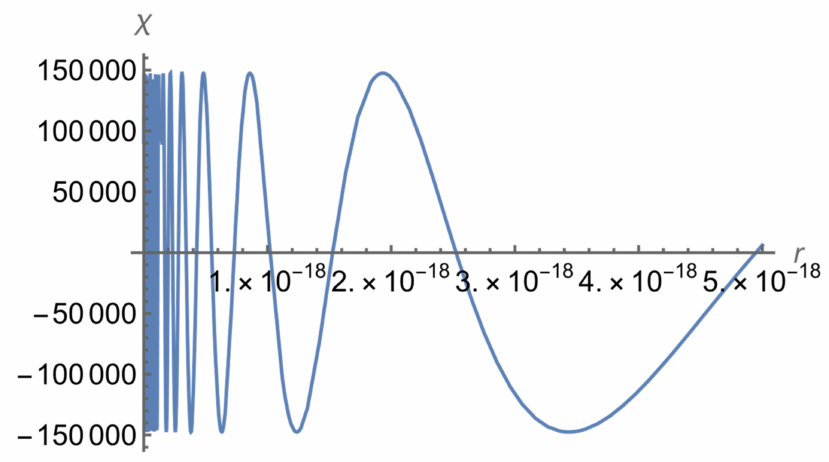
Figure 3. The normalized wave function of the bound E = 0 state of the neutron–neutron system for L = 3 at a relatively small r.